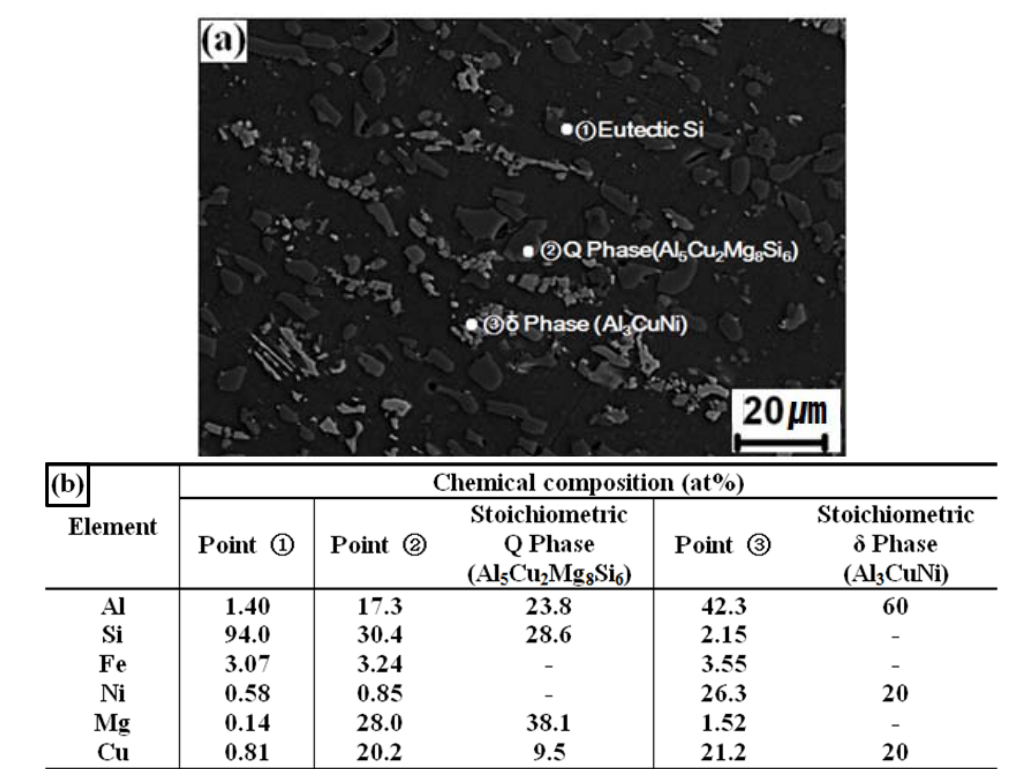
Figure 5. ( a ) SEM image; ( b ) EDS analysis data of the as ‐ received alloy.